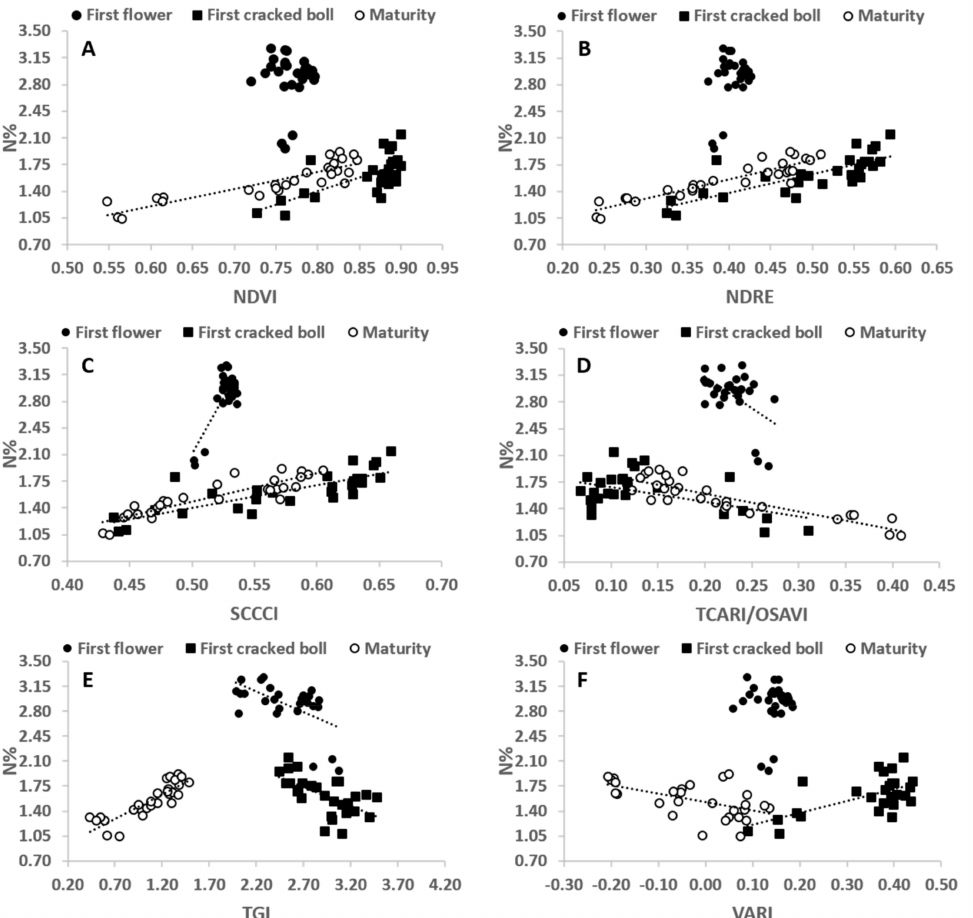
Figure 4. Relationships between plant nitrogen concentration (N%) and the normalized difference vegetation index (NDVI; A ), normalized difference red edge index, NDRE ( B ), simplified canopy chlorophyll content index (SCCCI; C ), transformed chlorophyll absorption reflectance index normalized by the optimized soil adjusted vegetation index (TCARI/OSAVI; D ), triangular greenness index (TGI; E ) and visible atmospherically resistant index (VARI; F ) at first flower, first cracked boll and